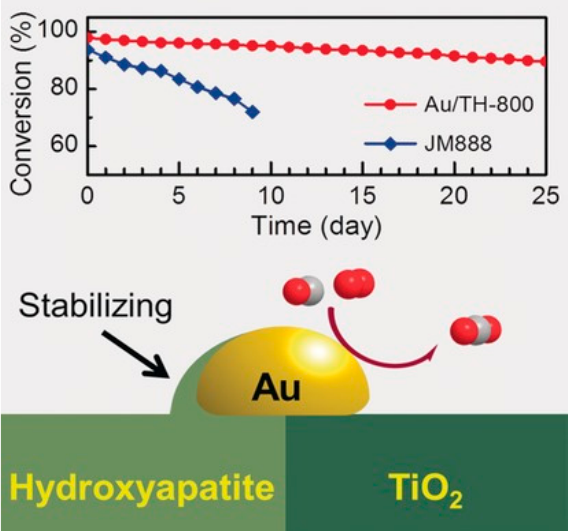
Figure 8. Schematic illustration of TiO 2 -HAP supported Au nanocatalyst with high stability owing to the OMSI between Au and HAP with TiO 2 , where the upper part shows CO conversion versus reaction time of the Au/TH-800 and commercial three way catalyst JM888 at 400 °C. Reproduced with permission from [47], copyright: 2016 John Wiley and Sons.